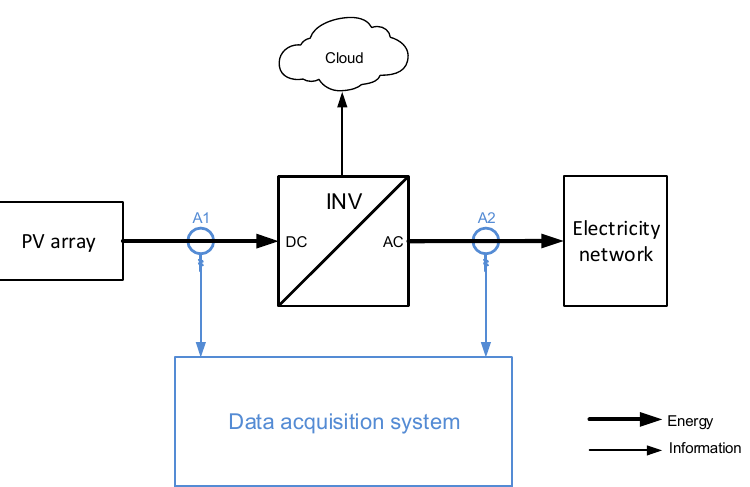
Figure 5. The measurement structure of the electrical parameters for the inverter (INV—inverter, A1—measuring point of DC electrical parameters, A2—measuring point of AC electrical parameters. Black blocks represent electrical equipment and stationary data recording system; blue blocks represent the installed data acquisition system for inverter efficiency evaluation).